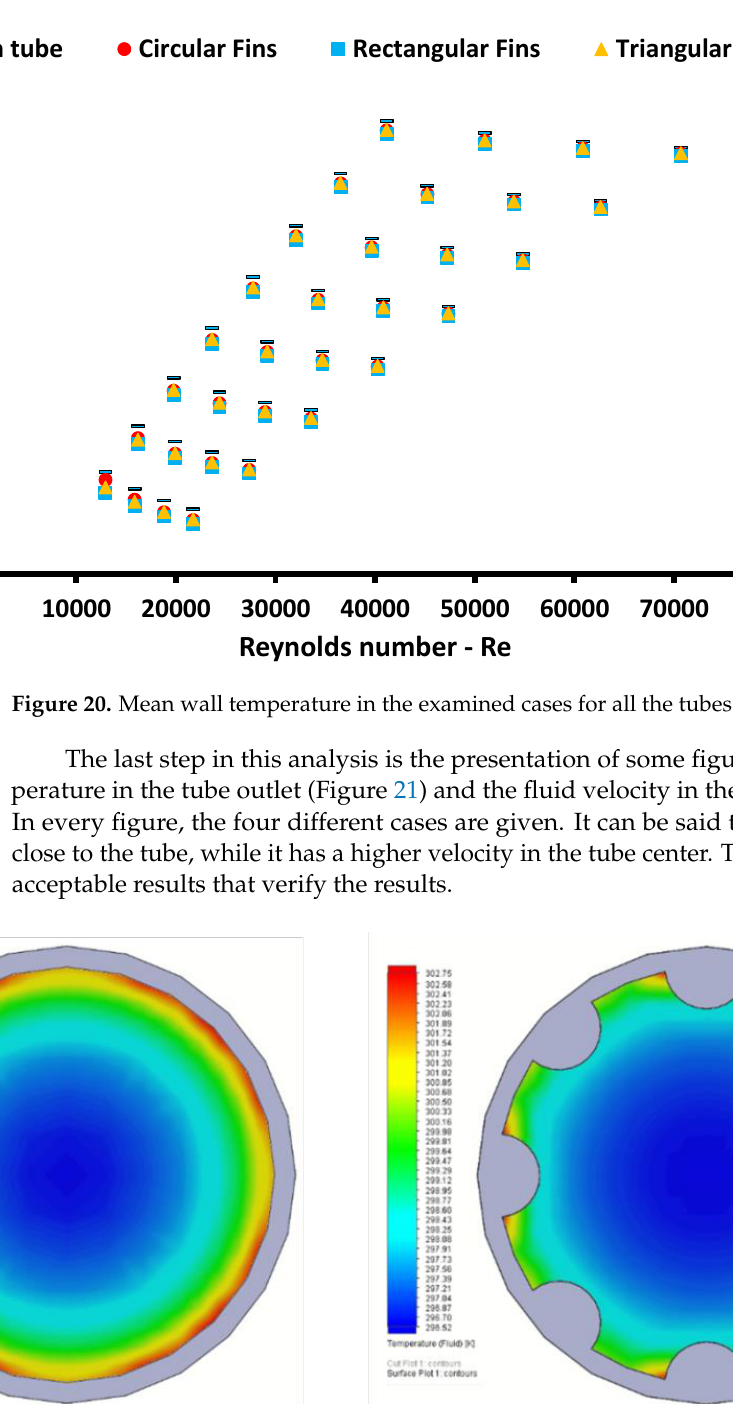
Figure 19. Bejan number in the examined cases for all the tubes.